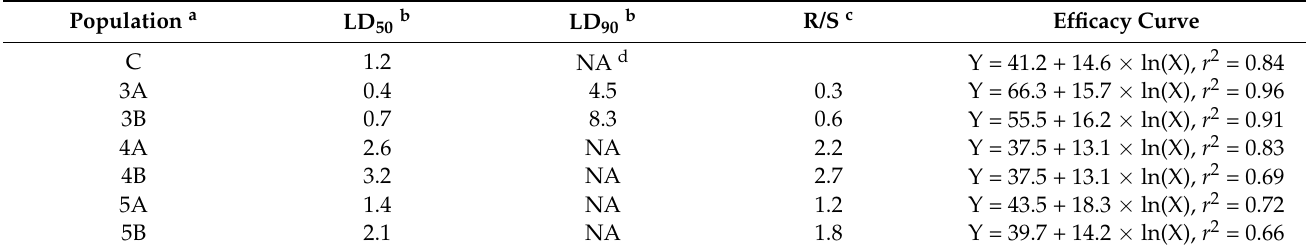
Table 3. Waterhemp population control with S -metolachlor under germination chamber